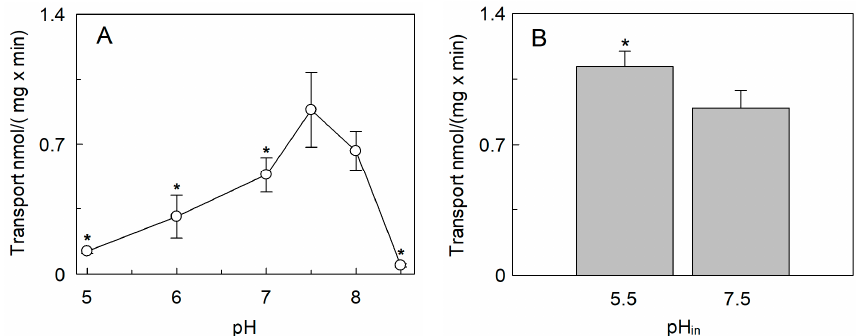
Figure 2. Effect of pH on the transport activity of SlCAT2 in proteoliposomes. Sl CAT2 was purified and reconstituted in proteoliposomes as described in Section 4.4. ( A ) Transport rate (nmol/(mg × min)) was measured in 10 min, as described in Section 4.5, by adding 100 µM [ 3 H]Arg to proteoliposomes containing 200 mM sucrose and 15 mM ATP. The pH was kept equal in both the internal and external site of proteoliposomes. ( B ) To generate the pH gradient, transport was measured in 10 min, as described in Section 4.5, by adding 100 µM [ 3 H]Arg (pH 7.5) to proteoliposomes prepared using the buffer at pH 7.5 or pH 5.5, as indicated (pH in ) and containing 200 mM sucrose and 15 mM ATP. Results are the means ± SD from three experiments. (*), Significantly different, from the control at pH in 7.5, for p < 0.05 as calculated from the Student’s t -test analysis.